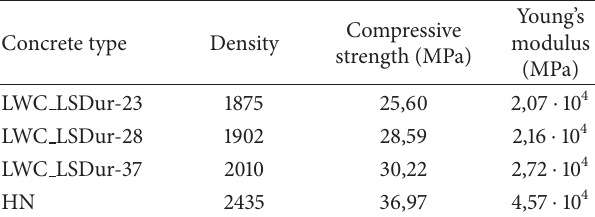
Table 1: Mechanical properties of studied concrete.